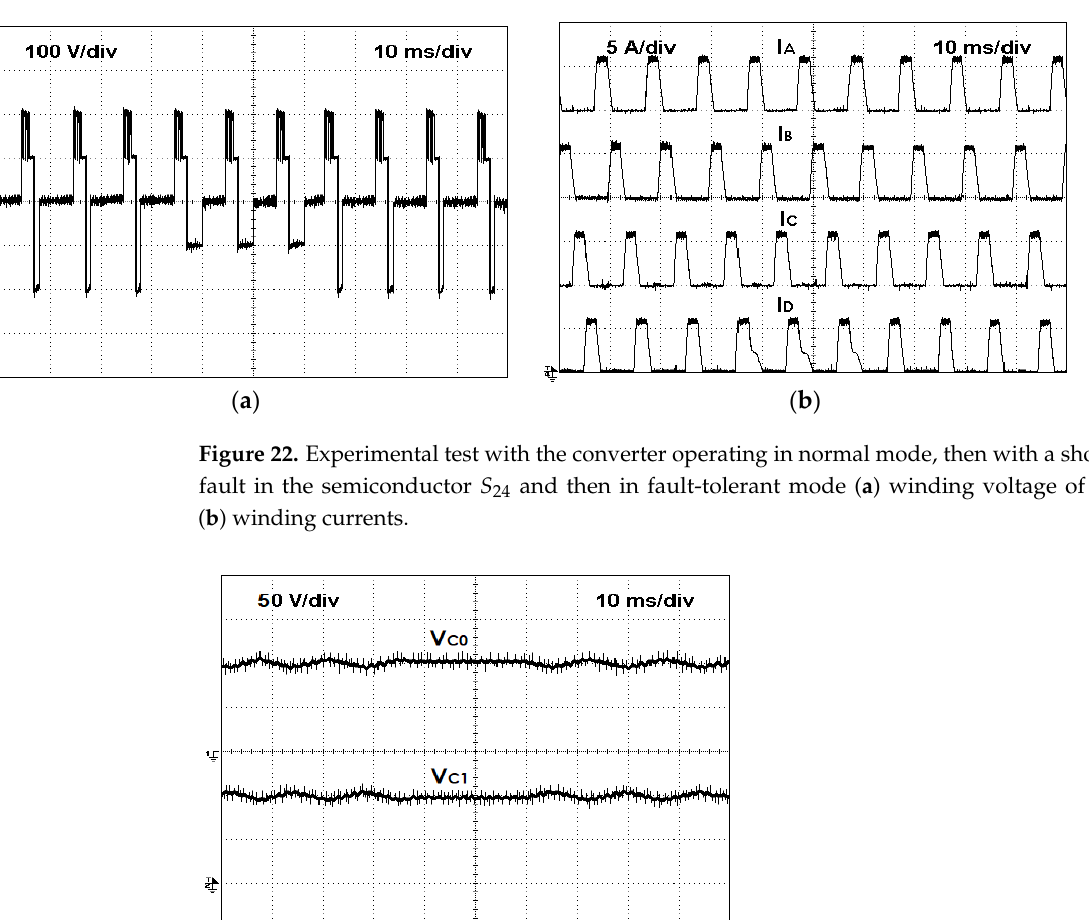
Figure 23. Experimental result of the voltages of both capacitors operating in normal conditions and after a short-circuit fault in the semiconductor S 24 .